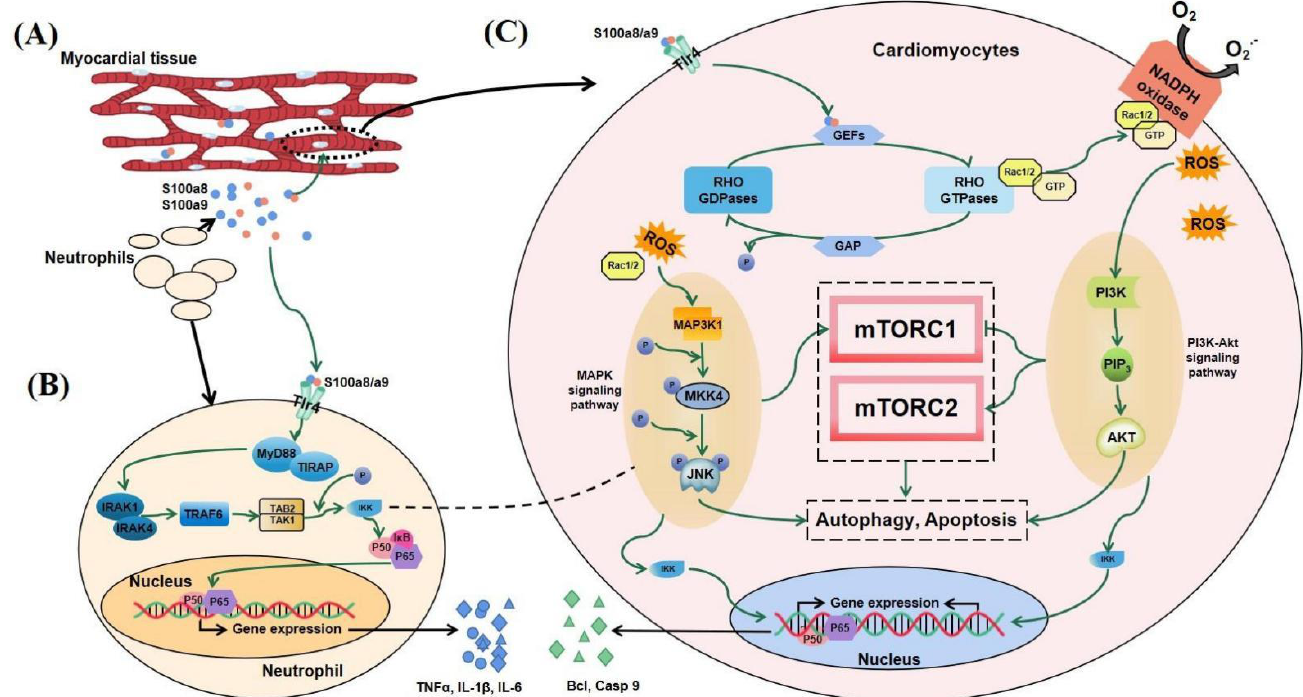
Figure 9. Possible mechanism diagram of S100a8/a9 regulating autophagy and apoptosis in the early stage of MI. ( A ) Neutrophils transfer to the injured area of MI and release S100a8/a9. Part of S100a8/a9 returns to neutrophils to regulate gene expression ( B ), and the other part enters cardiomyocytes to regulate cell death ( C ).